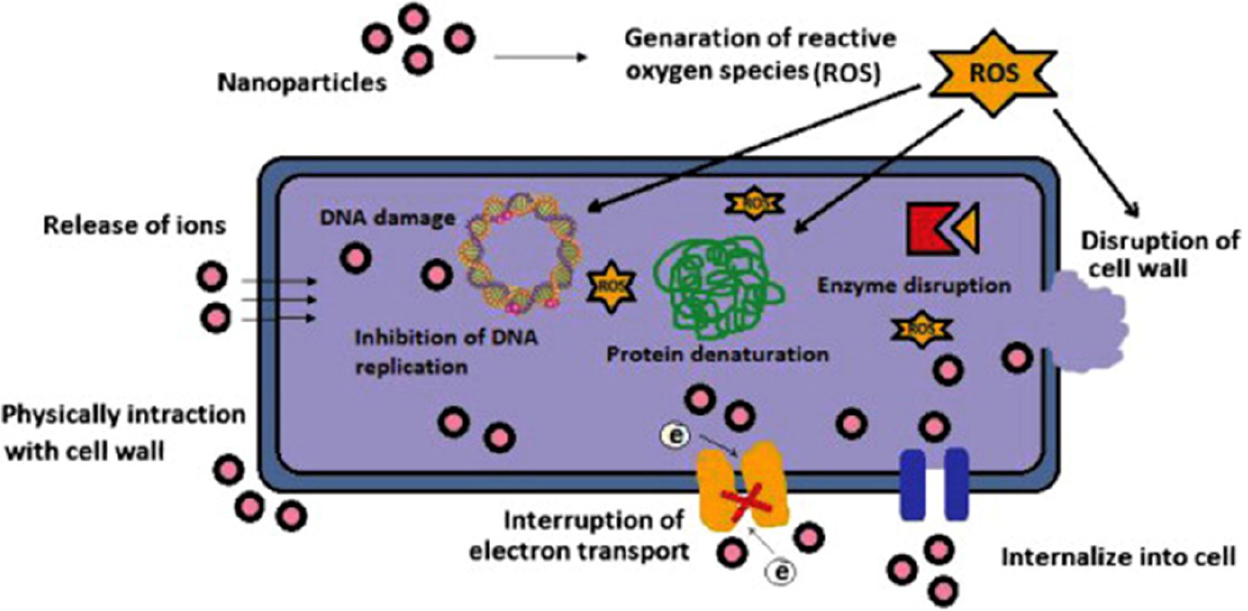
Figure 4. The scheme of a possible cell response to the influence of nanoparticles